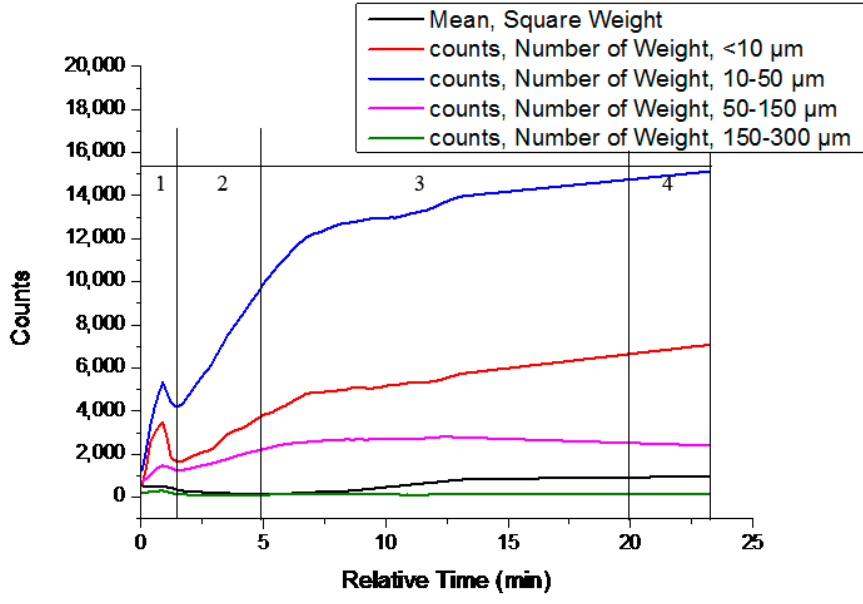
Figure 6. Variation curve of particle counts and mean of chord length in Experiment #4.